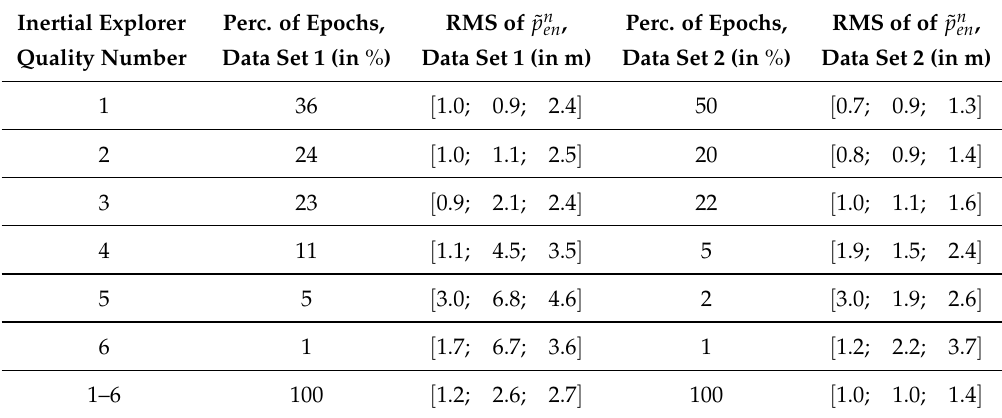
Table 10 details the performance of the most sophisticated algorithm version (multi-frequency/ multi-constellation with calibrated DCBs and odometry aiding) depending on the reference